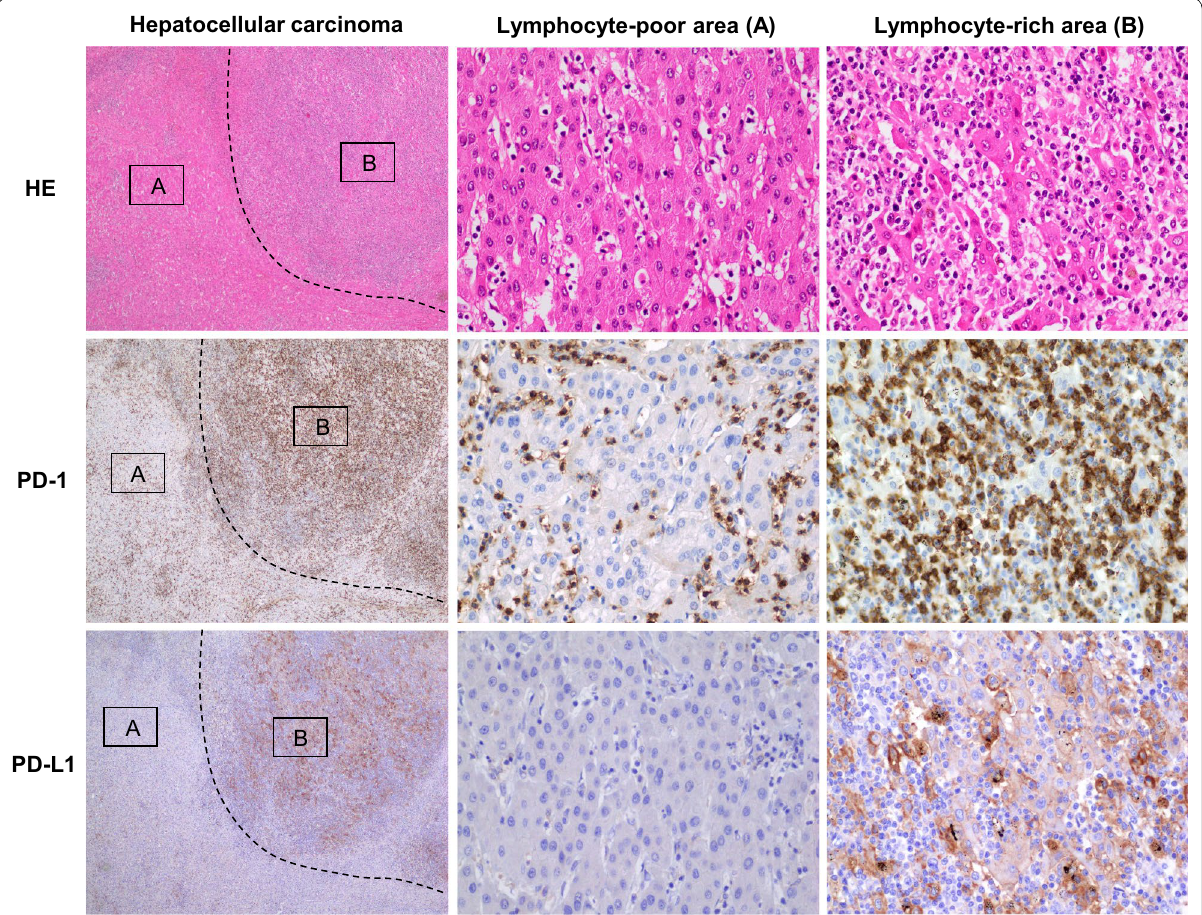
Fig. 6 Immunohistochemical expression of programmed death 1 (PD-1) and programmed death-ligand 1 (PD-L1) in hepatocellular carcinoma (HCC). Lymphocytes infiltrating the tumor stroma were positive for PD-1. The expression of PD-L1 was observed in carcinoma cells and macrophages specifically within the lymphocyte-rich area of